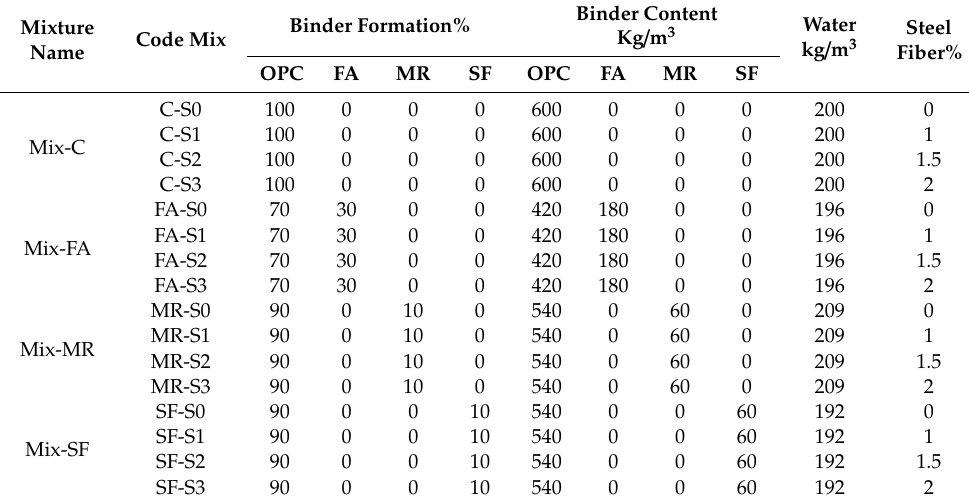
Table 3. Presentation of the admixture